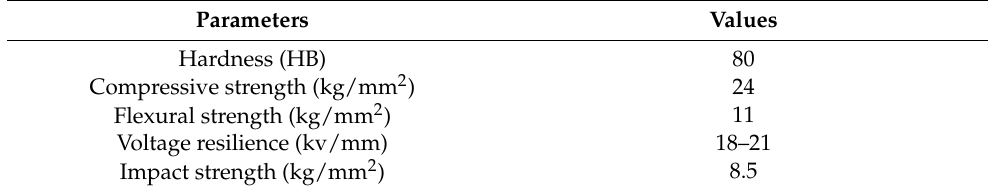
Table 2. Structural and material parameters of piezoelectric vibrator.